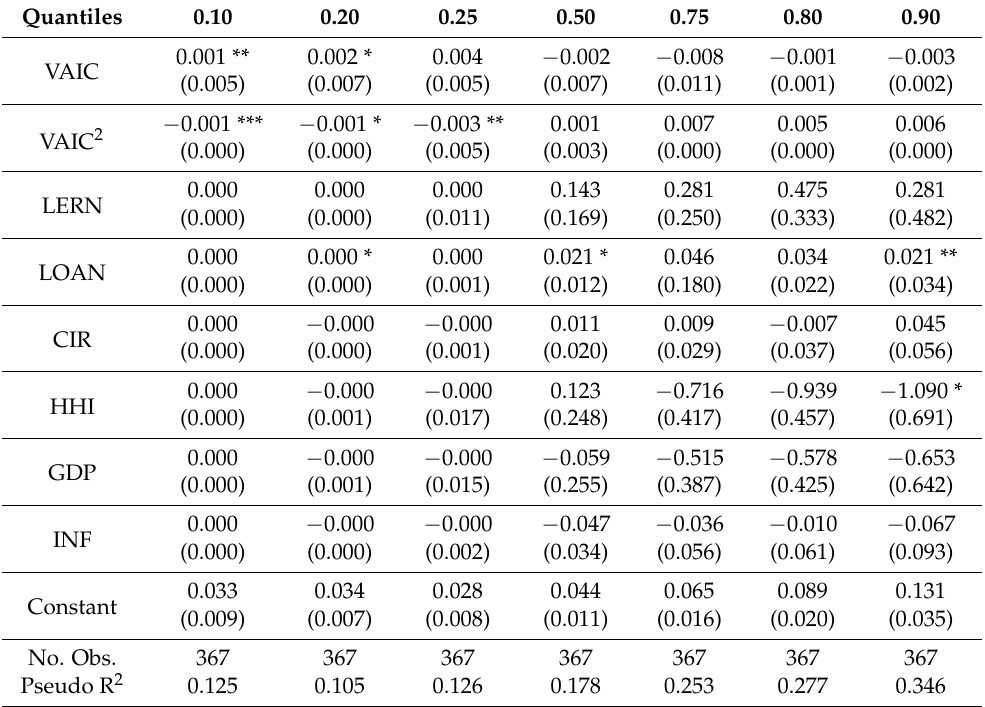
Table 5. Baseline results for NPL and VAIC : Quantile